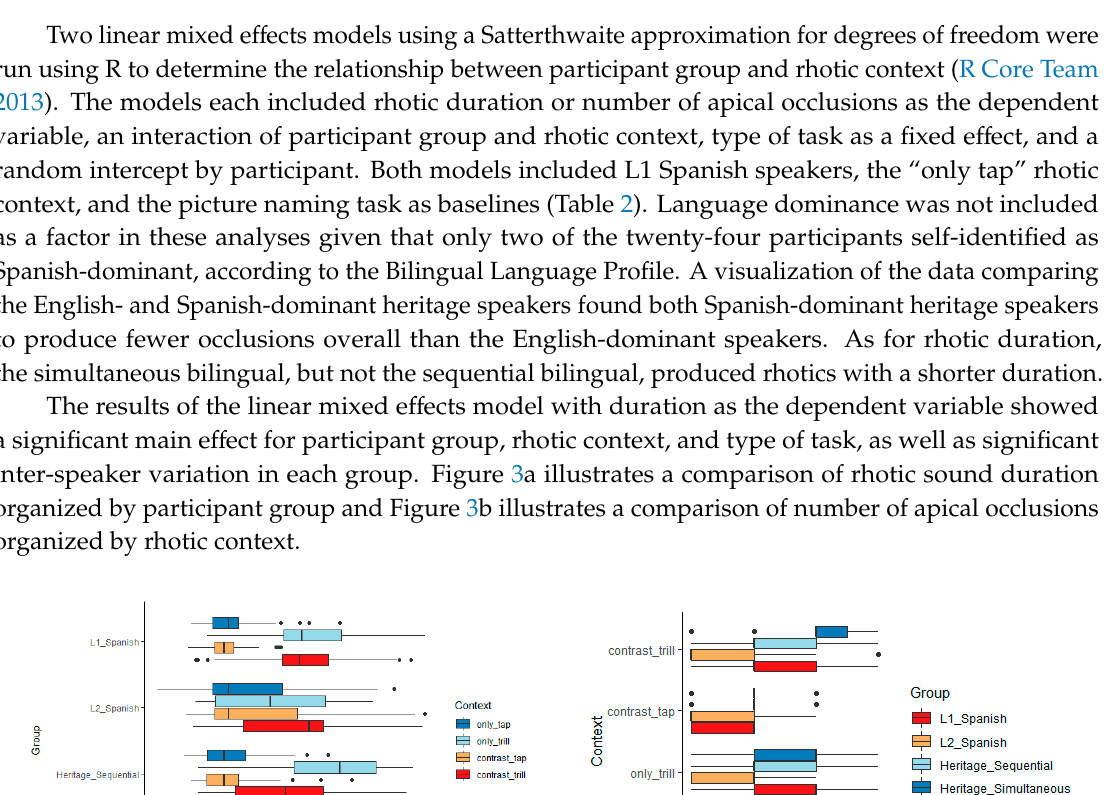
( b ) Figure 4. Bar plot for number of apical occlusions of the rhotic sounds according to participant group and ( a ) rhotic context and ( b ) phonemic tap. As for the interactions, the model analyzing rhotic duration found a significant interaction of L2 Spanish speakers and the “only trill”, “contrast tap”, and “contrast trill” contexts, simultaneous bilingual heritage speakers and the “contrast tap” context, and sequential bilingual heritage speakers and the “contrast tap” context. The model analyzing number of apical occlusions showed significant